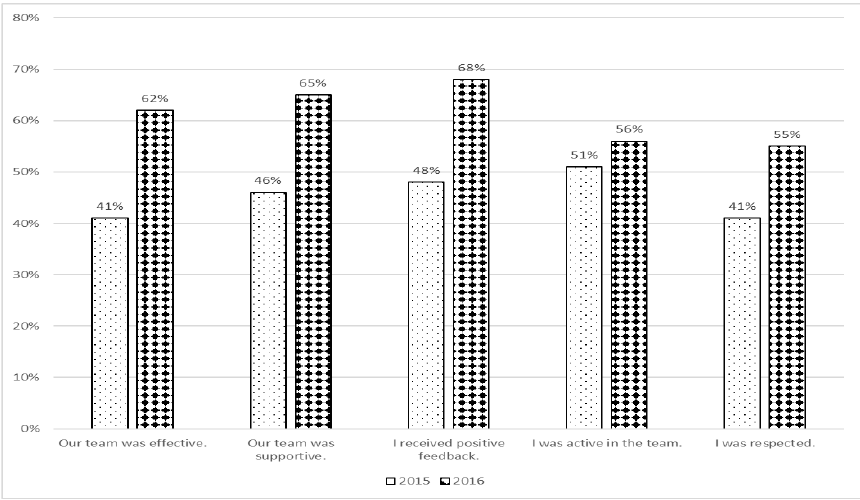
Fig. 4. Are learning groups